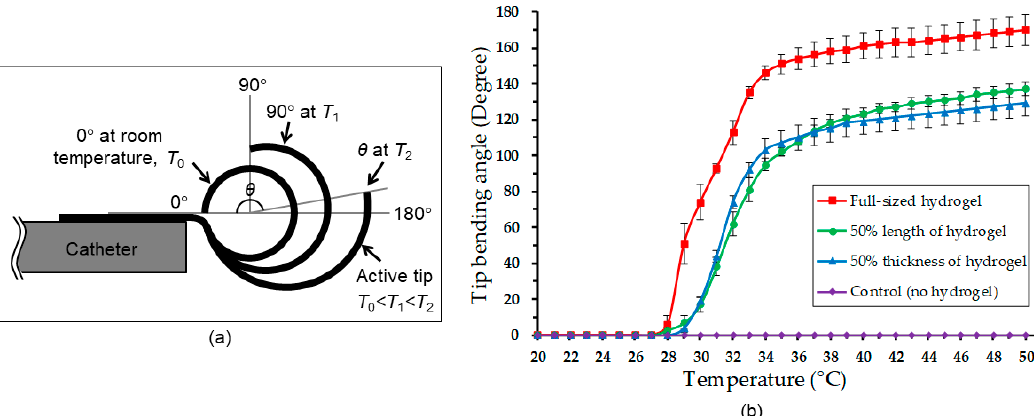
Figure 5. Thermomechanical characterization: ( a ) Illustration of bending angle measurement based on optical imaging showing three different states of the device tip at different ambient temperatures; ( b ) the bending angles of the fabricated prototypes with different hydrogel dimensions (20 mm or 10 mm length, 0.5 mm or 0.25 mm thickness) measured in a deionized (DI) water bath while varying water temperature up to 50 °C.